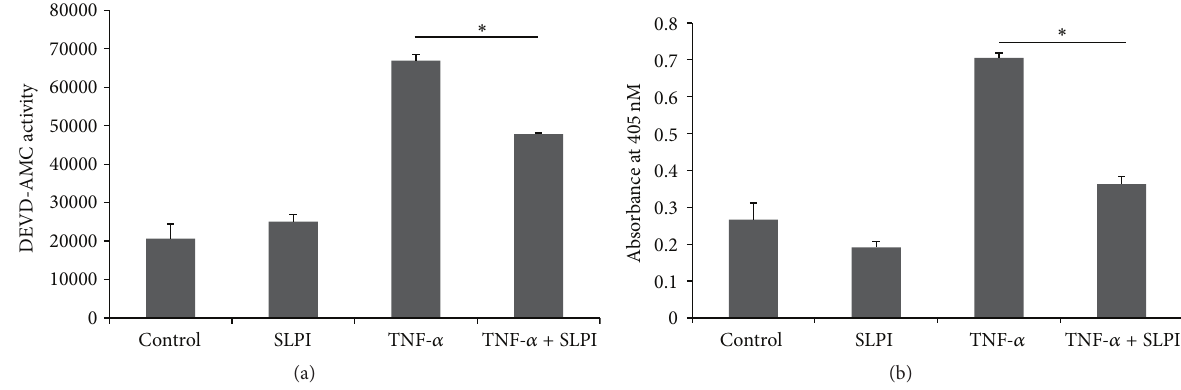
Figure 1: Effect of SLPI on TNF- 𝛼 -induced caspase-3 and caspase-7 activity and cell death. U937 monocytic cells were pretreated for 1hr with SLPI (10 𝜇 g/mL) and stimulated with TNF- 𝛼 (10ng/mL) for 4hr. (a) Activity of the effector caspases, caspase-3 and caspase-7, was measured using the fluorogenic substrate DEVD-AMC. Results are representative of 𝑛 = 6 . (b) The amount of apoptosis occurring in cells was measured by ELISA. Results are representative of 𝑛 = 6 experiments. ∗ indicates 𝑝 < 0.05 .